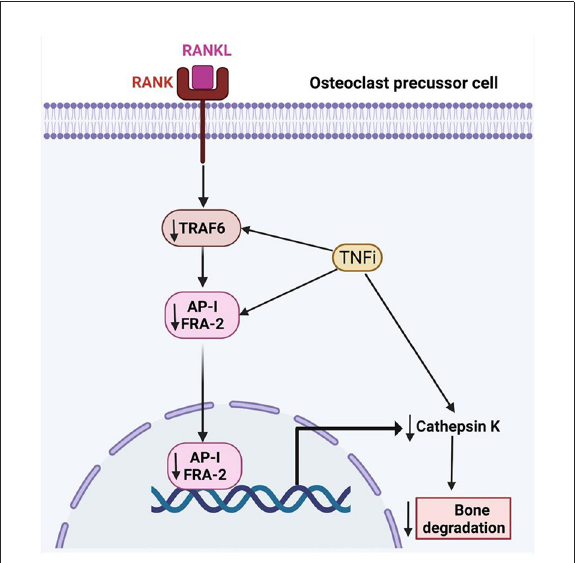
FIGURE2 The effects of tumor necrosis factor inhibitors on RA-related bone loss. TRAF6, TNF-receptor associated factor-6; FRA-2, Fos-related antigen-2; AP-1, Activator protein 1; RANK, receptor activator of nuclear factor kappa-B; RANKL, Receptor activator of nuclear factor kappa-B